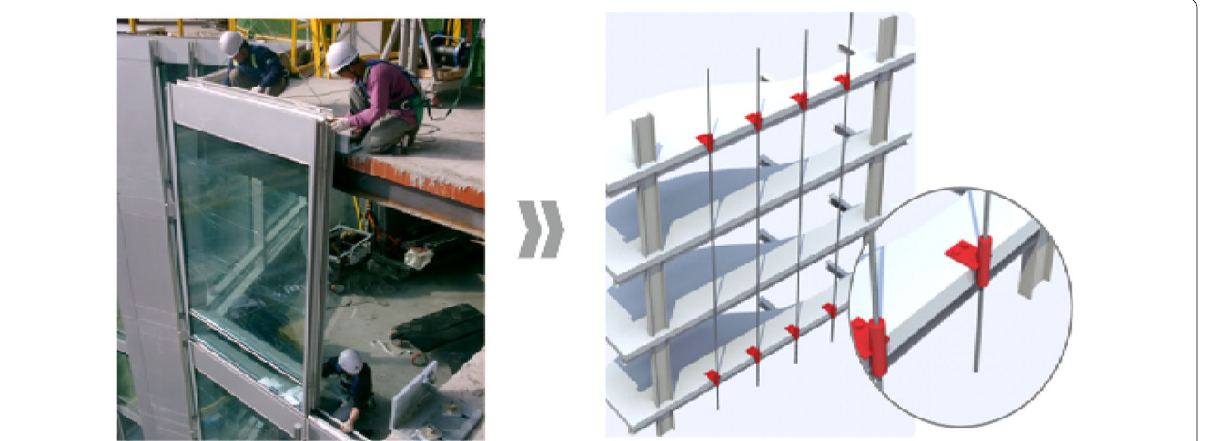
Fig. 1 Comparison of alum. C/wall system and cable C/wall system.